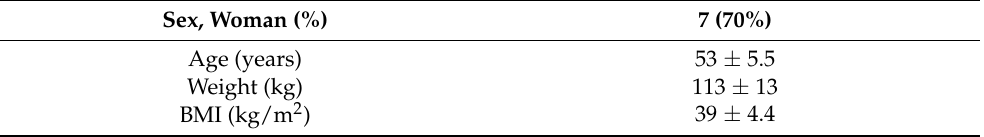
Table 1. Demographic and anthropometric characteristics of the 10 included